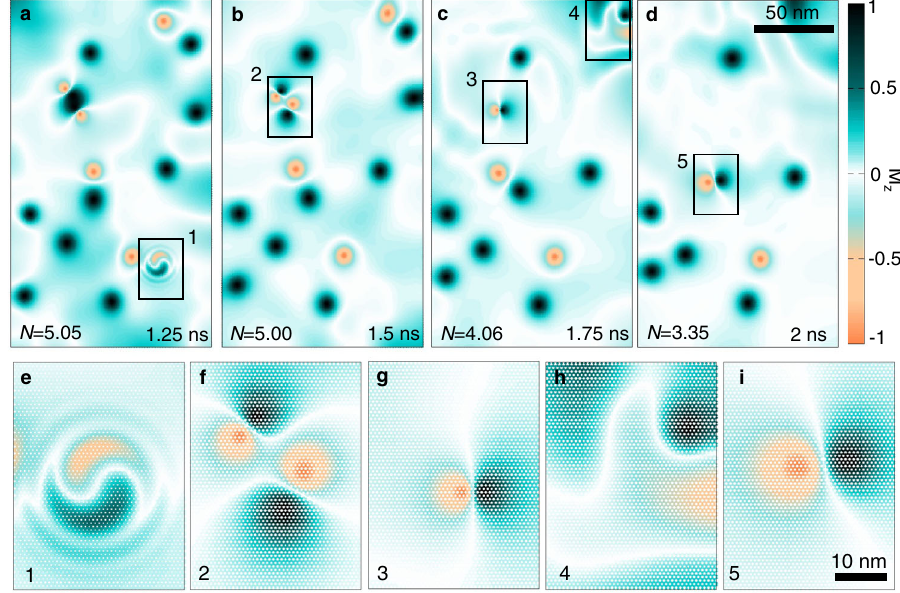
Fig. 3 Vortex and antivortex creation after light excitation. a , b Antivortex (vorticity w = − 1) formation with meron ( N ~ − 0.45) and antimeron ( N ~ 0.40) quasiparticle features, respectively. c Vortex ( w = + 1) stabilisation with antimeron characteristics ( N ~ 0.44). The big arrows in ( a , b ) indicate the average behaviour of the in-plane components in the perimeter of quasiparticle. d Creation of a higher order topological spin textures ( N = 0.95) composed of two antimerons. The variation of the magnitudes of N is observed within ± 0.03 within the area considered for the integration of Eq.